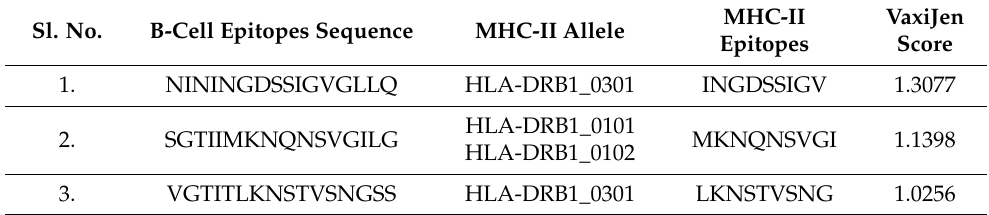
Table 2. Selected MHC-II epitopes of Fap2 based on VaxiJen Score > 1. Sl.